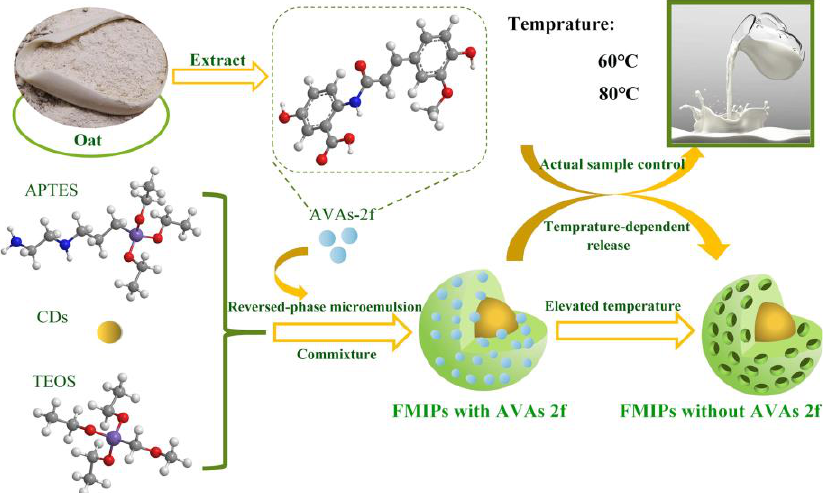
Scheme 1. Schematic diagram of the preparation of FMIPs and its application in the inhibition of AGEs.